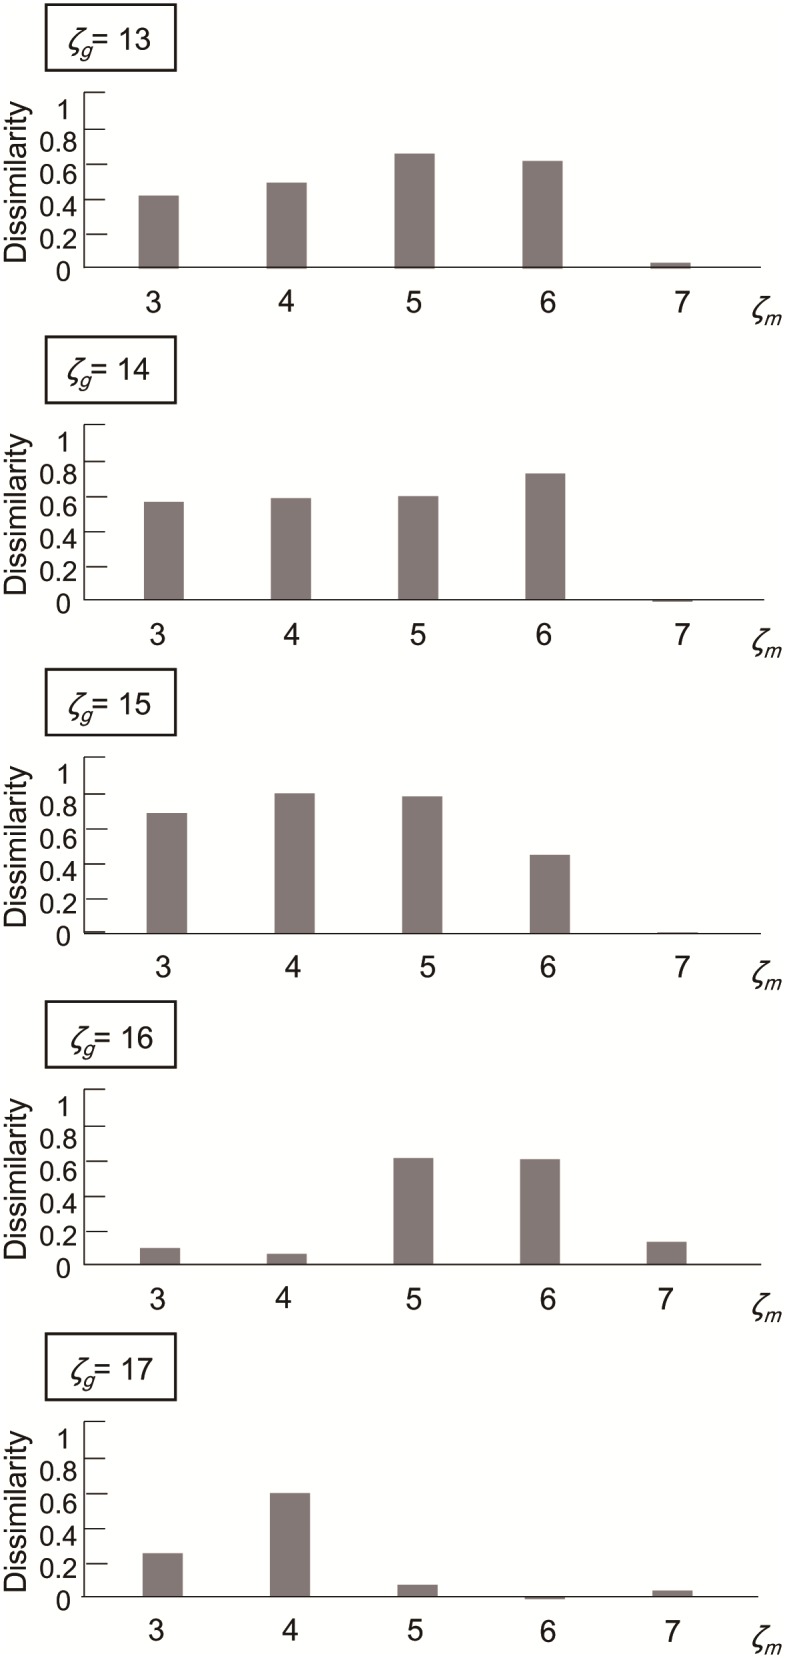
Parameter set ζm, ζg and prediction accuracy.Pearson correlations between dissimilarity index E and discrimination rate of the mice obtained from experiments are plotted with different ζg and ζm.